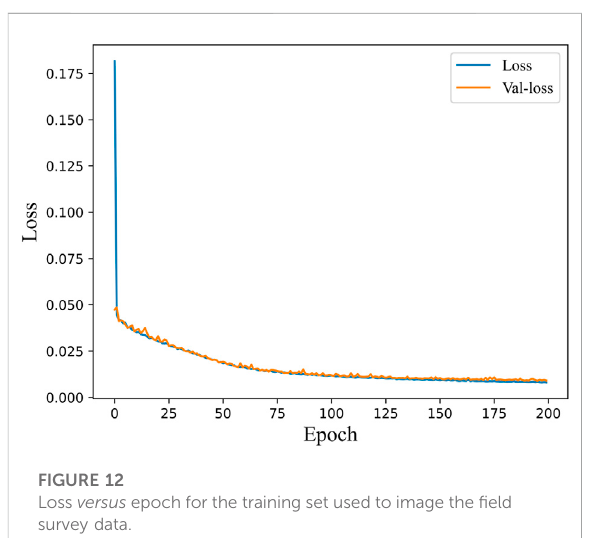
Frontiers in Earth